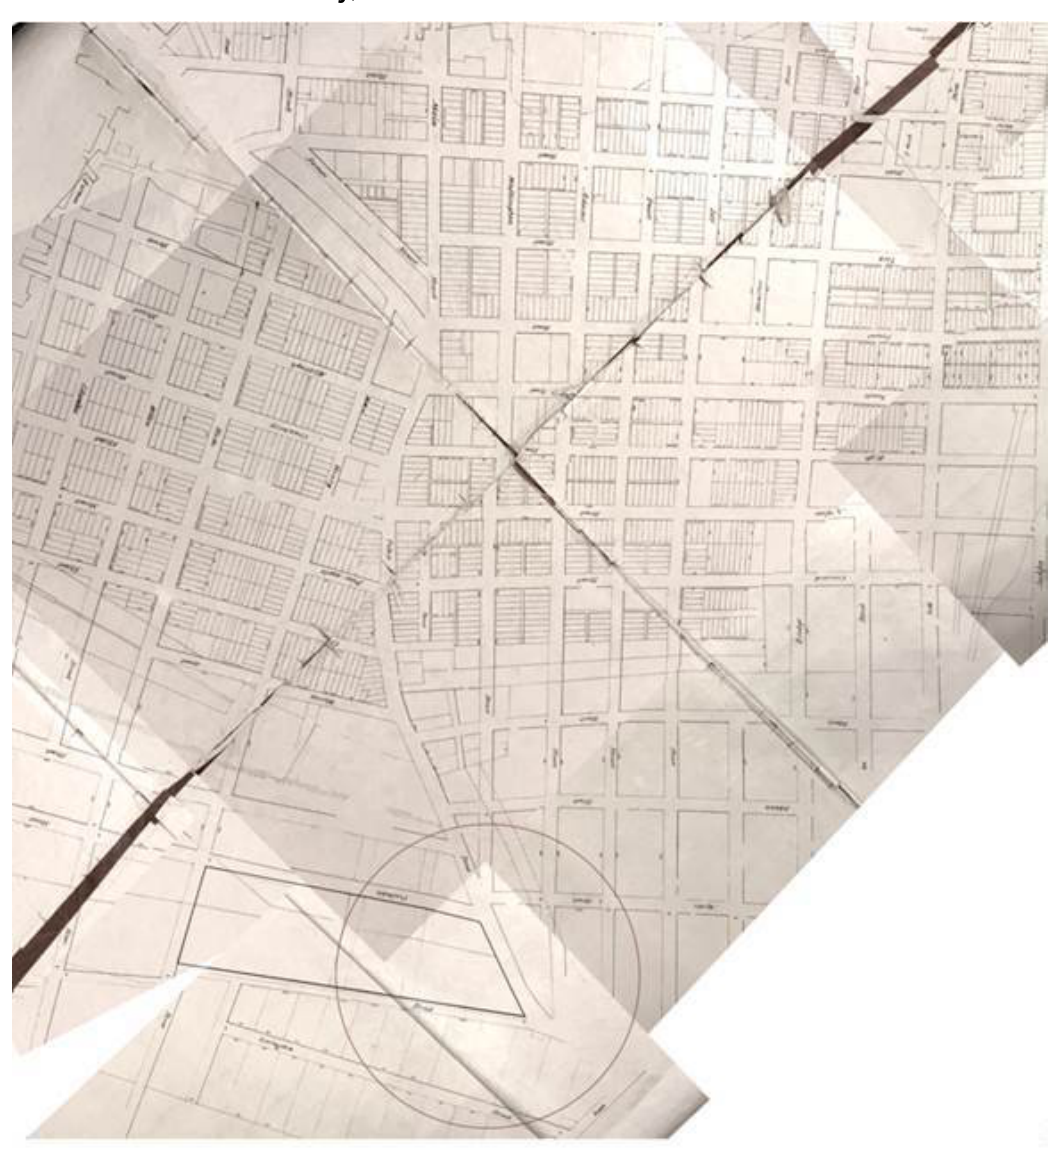
Figure 5. Facsimile of the Approved Map of Brooklyn Village 1819. The circle indicates the future location of City Hall; the long block that will be subdivided for the City Hall site is highlighted (Source: New York Public